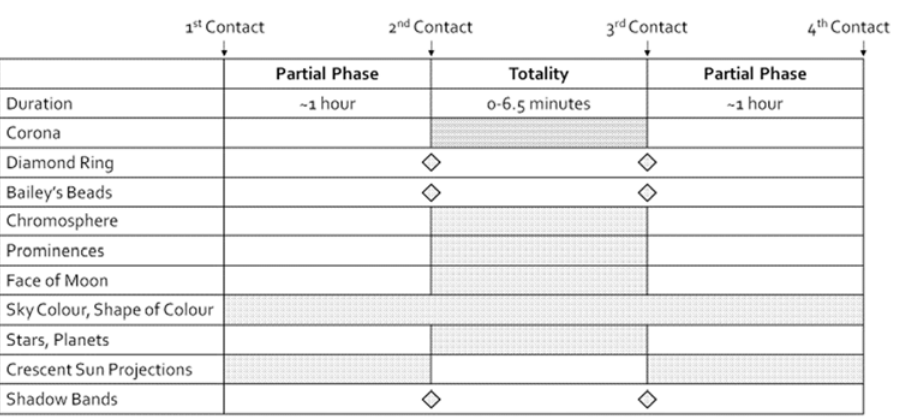
Table 1. Chronology of